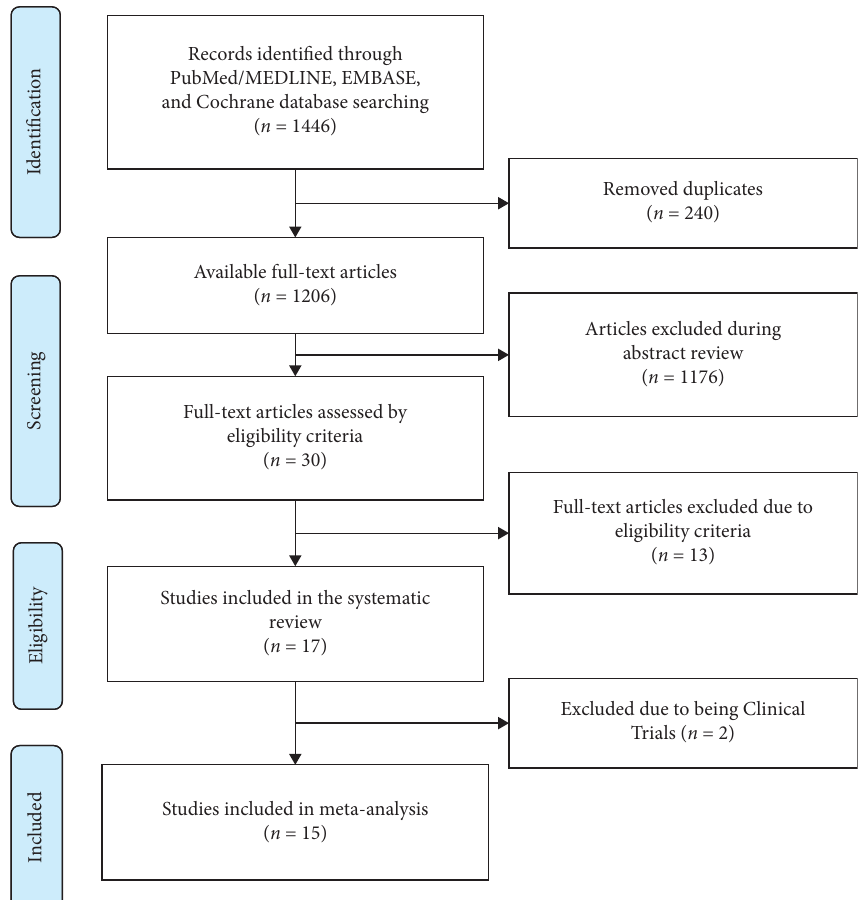
Figure 1: PRISMA flow